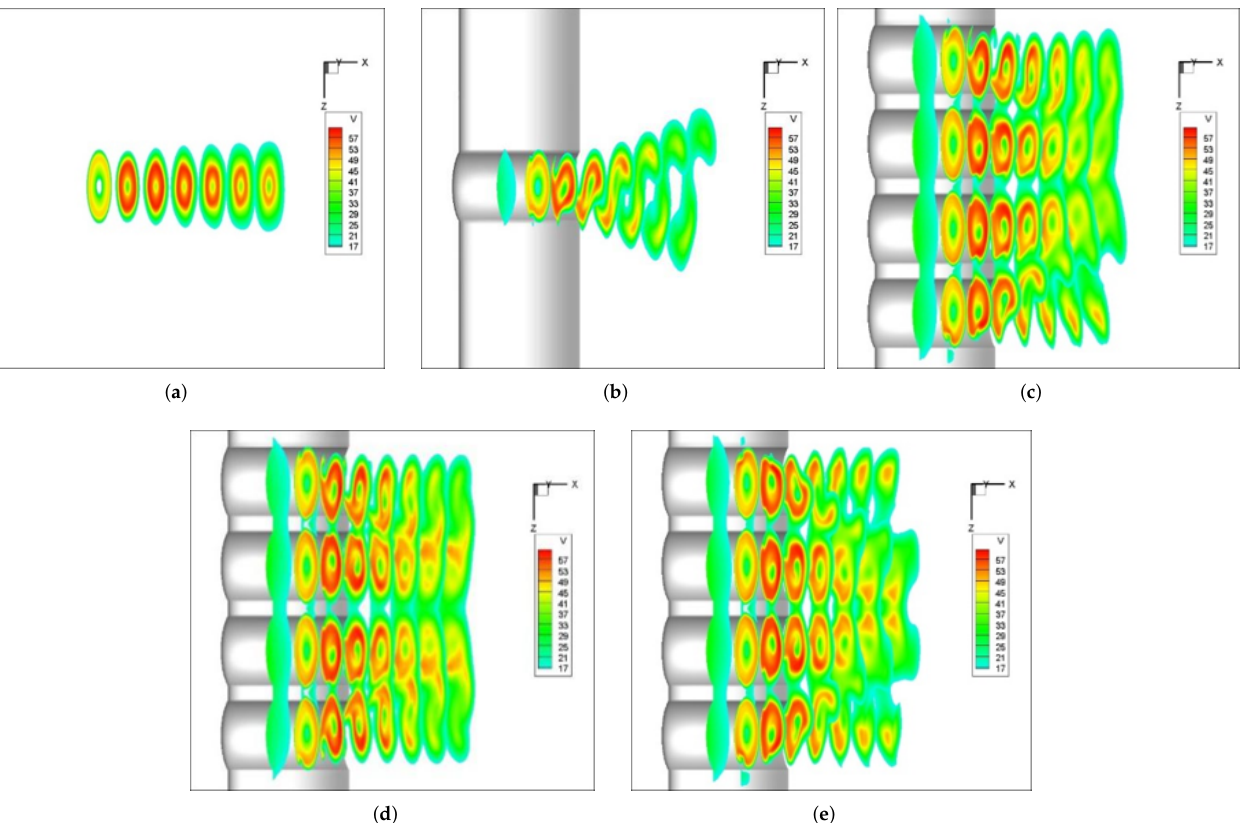
Figure 14. Velocity contour of different configuration. ( a ) Isolated propeller; ( b ) Single propeller channel wing; ( c ) Multi-propeller CW (NNNN); ( d ) Multi-propeller CW (NPNP); ( e ) Multi-propeller CW